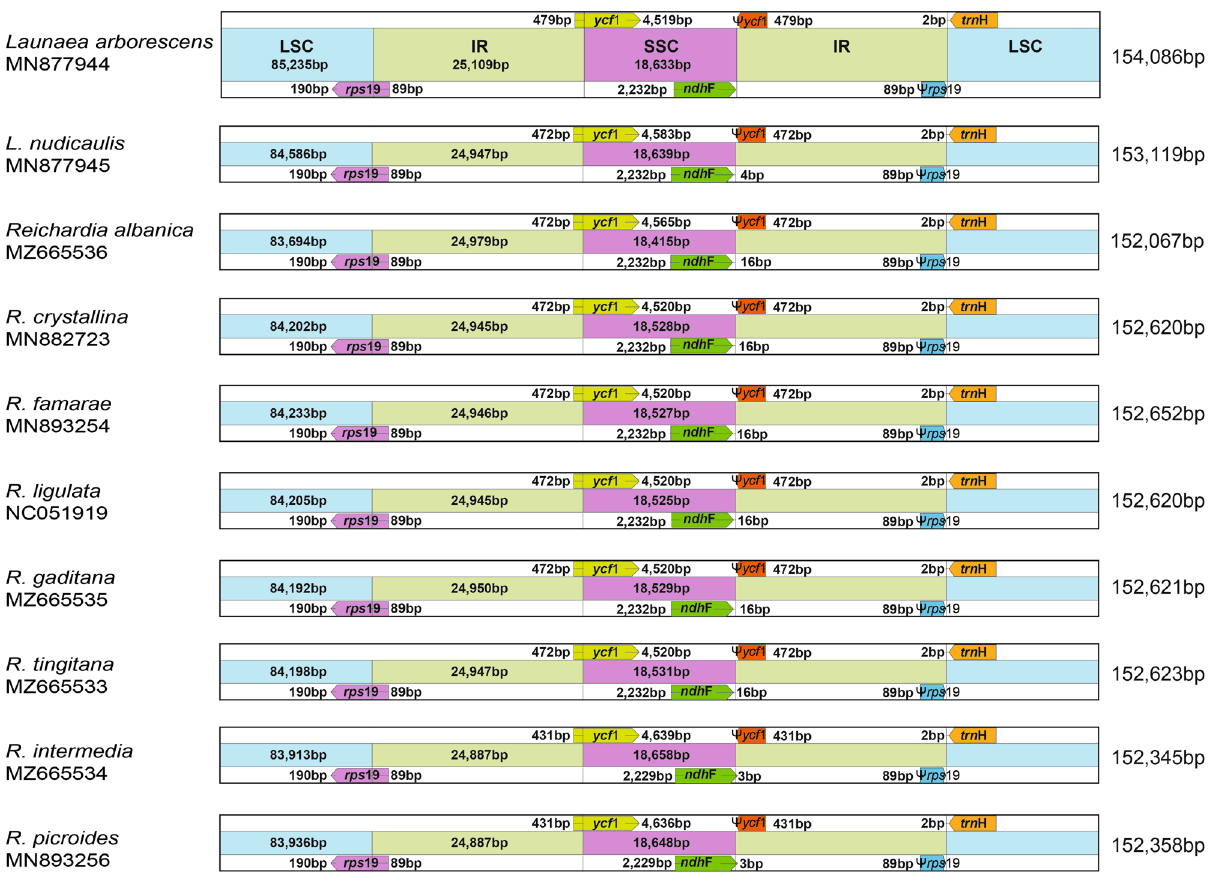
Figure 2. Comparison of the border positions of the large single copy (LSC), small single copy (SSC), and inverted repeat (IR) regions among eight Reichardia and two Launaea plastomes.